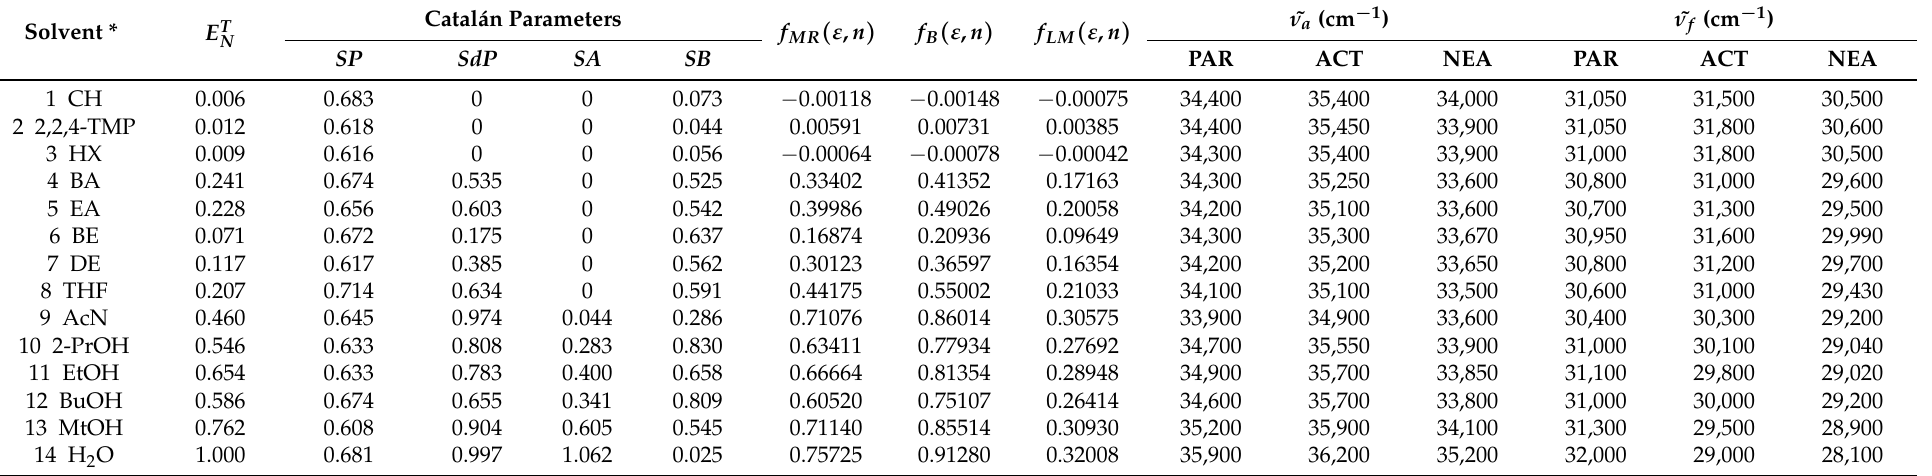
Table 1. Solvent parameters (E T and Catalán parameters) applied in the calculations, values of the solvent polarity functions ( f MR ( ε , n ) , f B ( ε , n ) , f LM ( ε , n ) ) and the position of the N long-wavelength absorption ( ˜ ν a ) and fluorescence ( ˜ ν f ) maxima of PAR, ACT, and